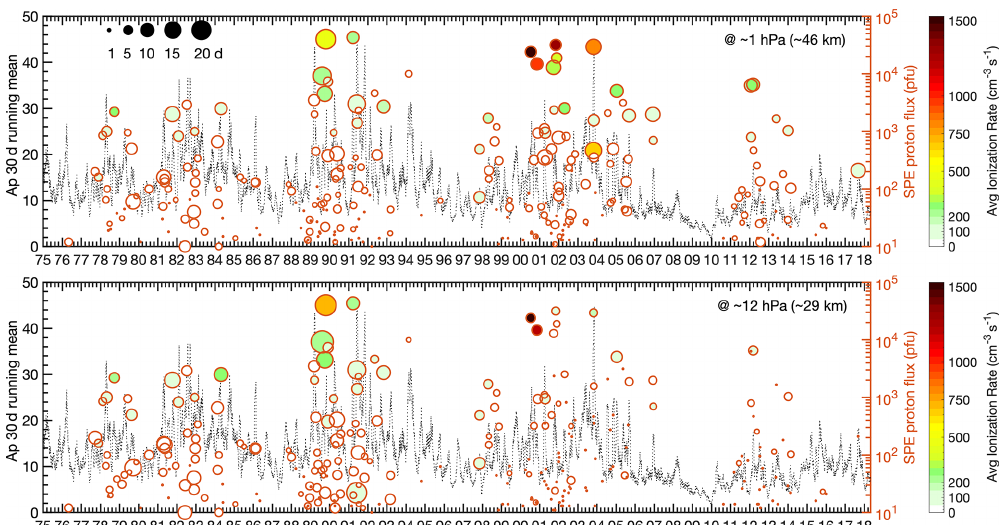
Figure 1. Onset time of SPEs and their proton fluxes since 1975. The filled colors are the average ionization rates during each SPE at ∼ 1hPa (upper panel) and ∼ 12hPa (lower panel), while the size of the markers represents the approximate duration of the SPEs obtained from the daily mean ionization rate at the two altitudes. The black dotted line in the background is the 30d mean of the daily geomagnetic activity